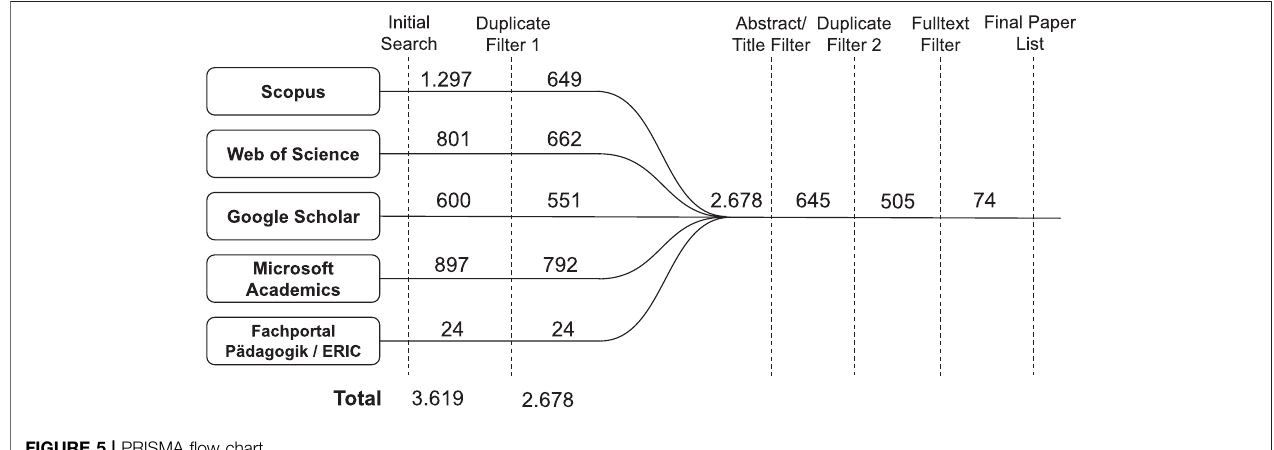
FIGURE 5 | PRISMA fl ow